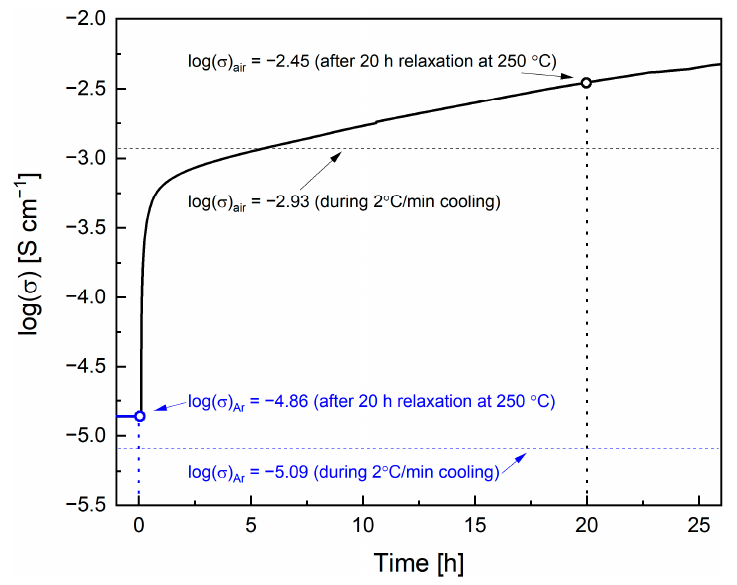
Figure 4. Conductivity relaxation data for Pr005 at 250 °C after a gas change from Ar to air. Blue and black horizontal lines indicate values of log( δ ) during 2 °C min − 1 cooling in Ar and air, respectively (see Figure 3c).